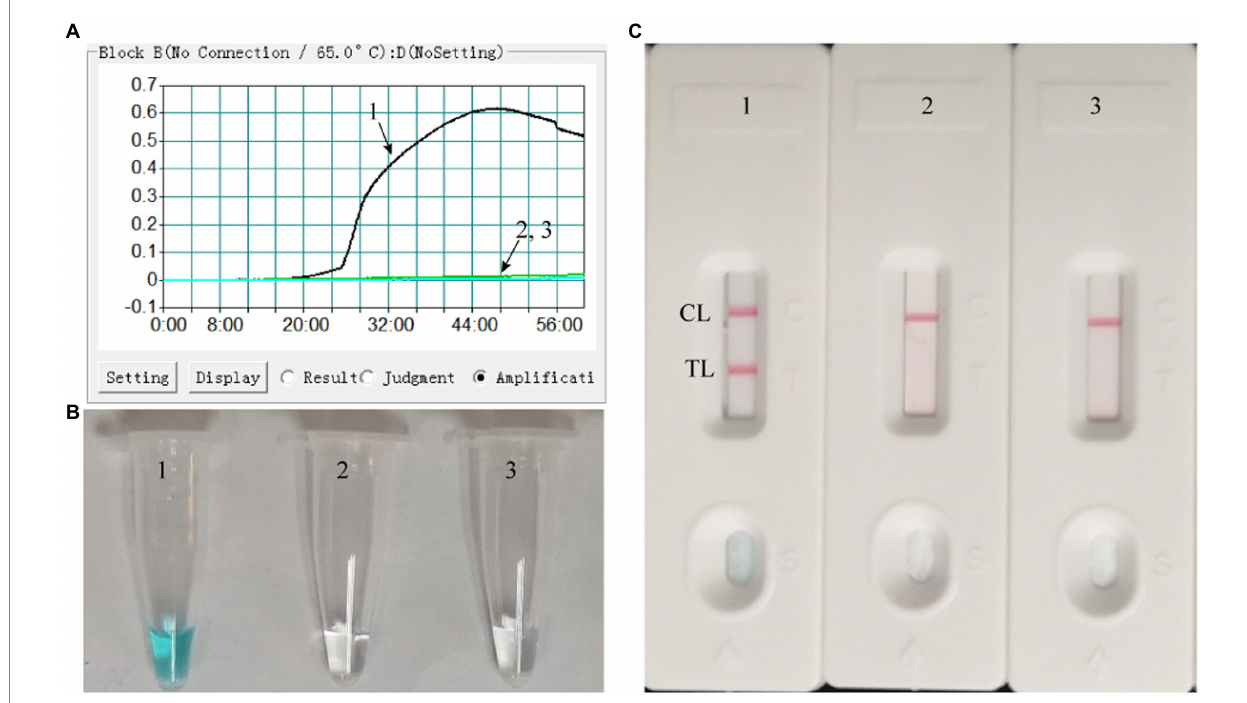
FIGURE 2 Effectiveness of the primer set for the MPX-LAMP-LFB assay. The effectiveness of the primer set for the MPX-LAMP-LFB assay was verified by testing the LAMP products with real-time turbidity (A) , visual detection reagent (B), and LFB (C) methods. Curve/Tube/Biosensor 1, the ATI-plasmid that used as positive control, which was effectively amplified with LAMP reaction at 65 ° C; Curve/Tube/Biosensor2, the genomic DNA of influenza virus A that used as negative control; Curve/Tube/Biosensor3, the blank control